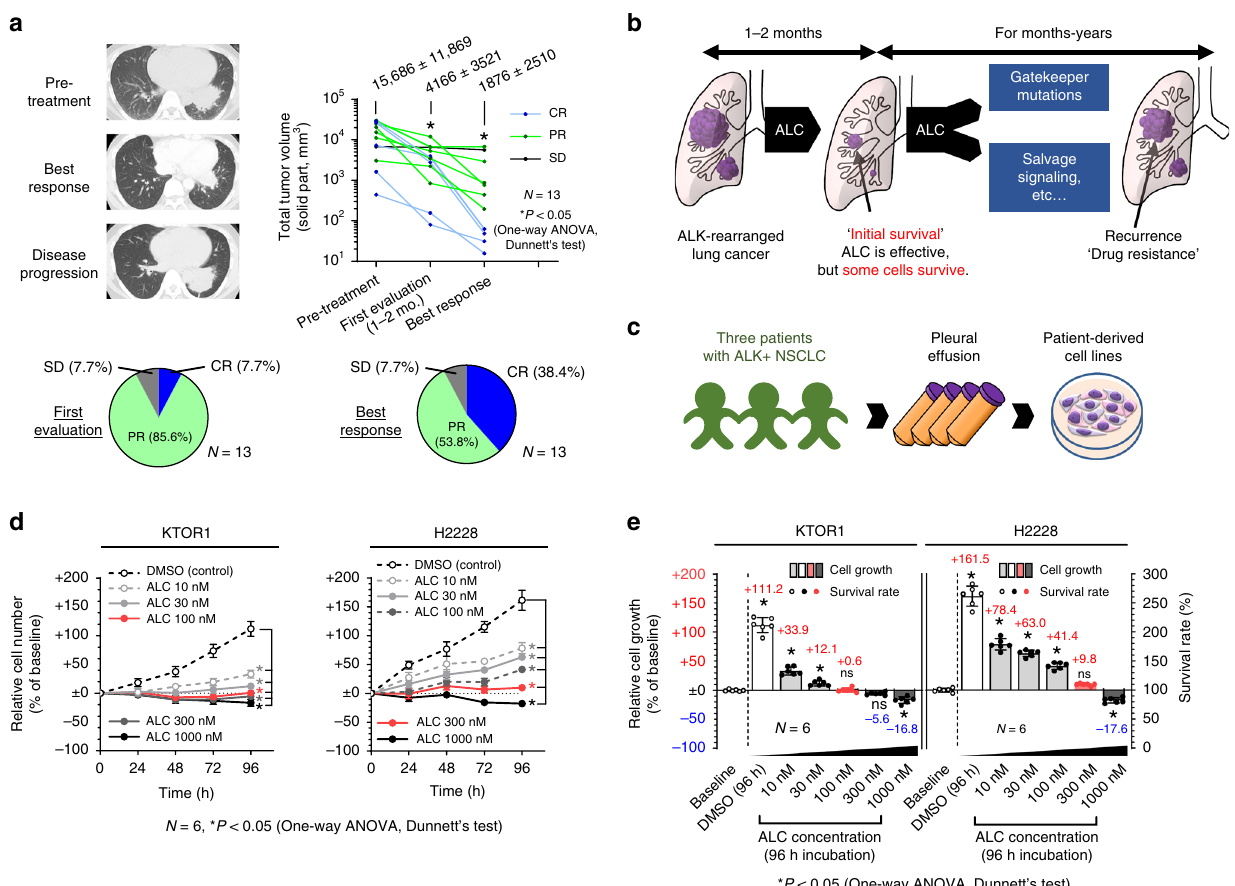
Fig. 1 A subpart of ALK-rearranged tumors survived the ALC treatment. a Tumor volumes in 13 patients with ALK-rearranged lung cancer receiving ALC as fi rst-line therapy in our institution. Representative CT image of a patient (top left). Changes in tumor volumes during the ALC treatment (top right). Signi fi cance was evaluated using a one-way ANOVA followed by Dunnett ’ s multiple comparison test. Tumor responses in 13 patients in the fi rst evaluation (1 – 2 months from treatment initiation) or at the best response (bottom). b Schematic explanation of initial survival from ALK inhibitors. ALK inhibitors exert speci fi c effects on ALK-rearranged tumors; however, some tumor cells survive (initial survival) this treatment. During months-years of treatment, tumors eventually relapsed with acquired resistance to ALK inhibitors. A waterfall plot of the changes in tumor diameter based on RECIST guideline are shown in Supplementary Fig. 1a. c Schematic explanation of the establishment of patient-derived cell lines. d – e Some ALK-rearranged NSCLC cells survived the ALC treatment; however, their proliferation was signi fi cantly suppressed under the ALC treatment in vitro. Proliferation tests ( d ) and initial survival rates ( e ) of KTOR1 and H2228 cells exposed to stepwise concentrations of ALC or DMSO ( n = 6 independent experiments). Signi fi cance was evaluated using a one-way ANOVA followed by Dunnett ’ s multiple comparison test. The survival rate was calculated using the formula: (Cell number at 96 h)/(Cell number at 0 h = baseline) × 100. Relative cell growth was calculated by (survival rate)-100. The positive columns indicate increased cell numbers during the 96-h treatment and negative columns indicate decreased cell numbers. The results for traced experiments in KTOR2 and KTOR3 were presented in Supplementary Fig. 1b, c. CR complete response, PR partial response, SD stable disease, ALK anaplastic lymphoma kinase, NSCLC non-small cell